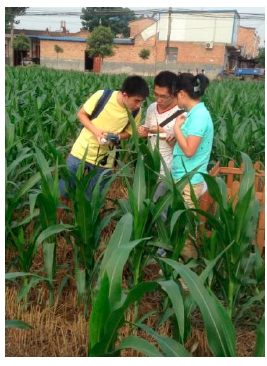
Figure 8. Farmland experiment. Figure 8. Farmland